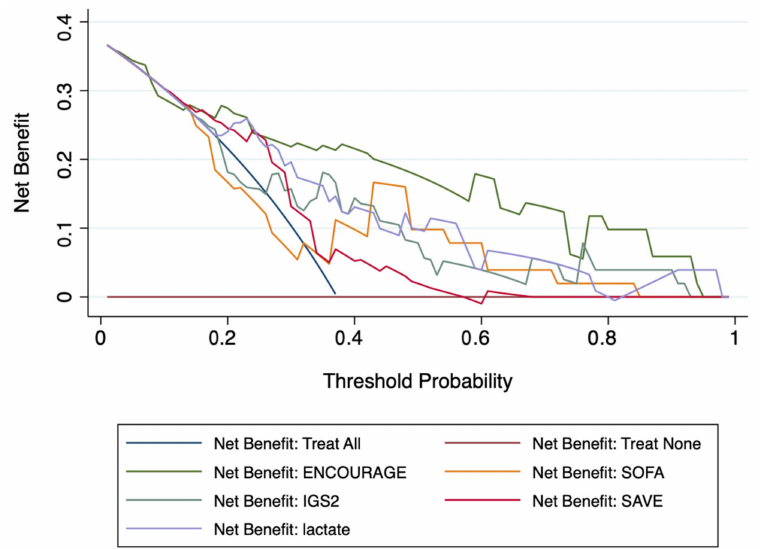
Figure 3. Decision curve analysis: net number of true positives gained using different models compared to no model at a range of thresholds